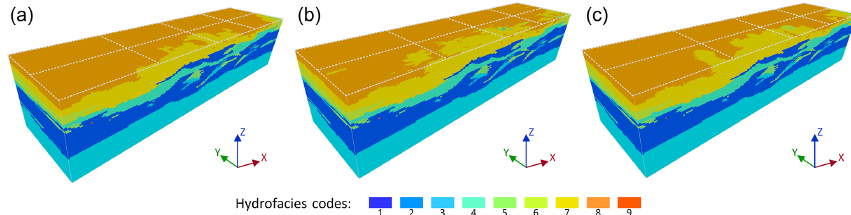
Figure 16. Three realizations using three different MPS approaches: (a) DS, (b) s2Dcd with the coordinate z as auxiliary variable and (c) 3DRCS with the coordinate z as auxiliary variable.